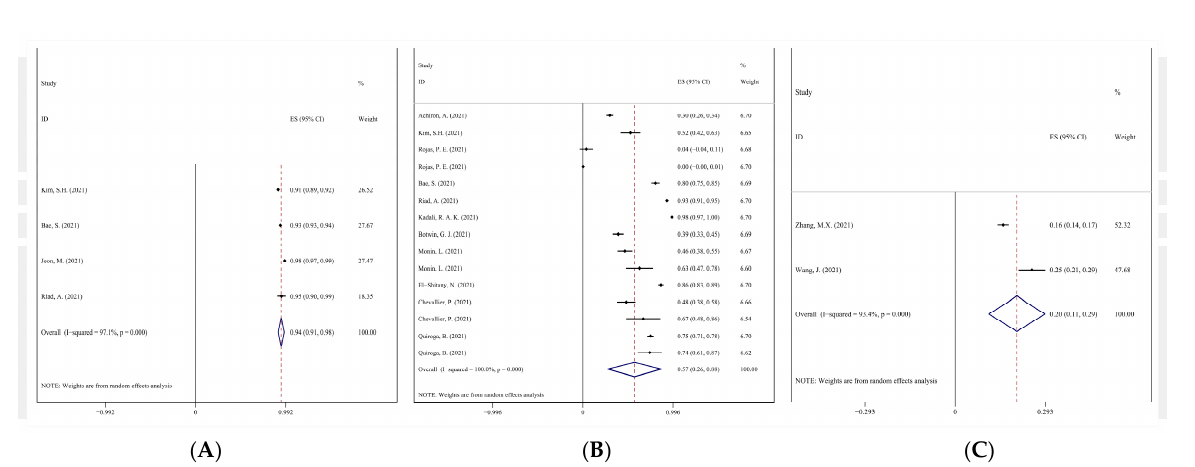
Figure 3. Forest plots of AEs in observational studies. ( A ) Forest plot of viral vector vaccine; ( B ) forest plot of AEs of mRNA vaccine in observational study; ( C ) forest plot of inactivated vaccine in observational study.